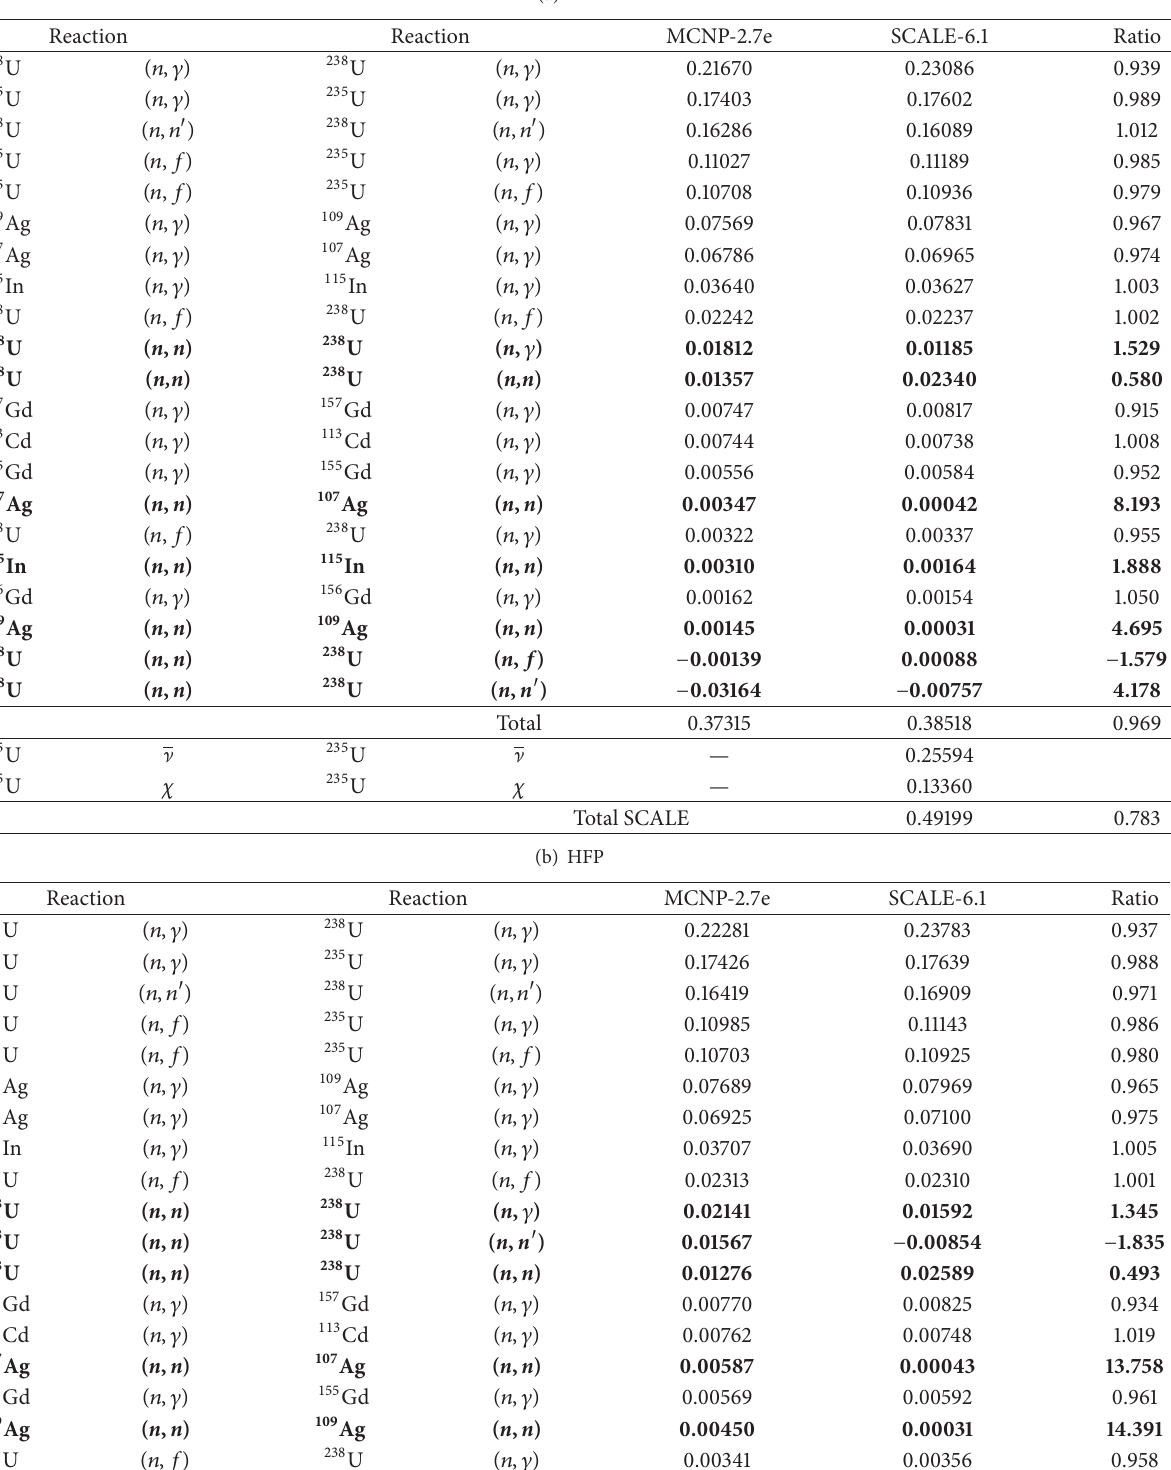
Table 4: Comparison of the uncertainty contribution to 𝑘 of each variance-covariance matrix of the reaction pair presented in the first two eff columns given in rel.std.dev.(%) calculated by SCALE-6.1 and MCNPX-2.7e for rodded